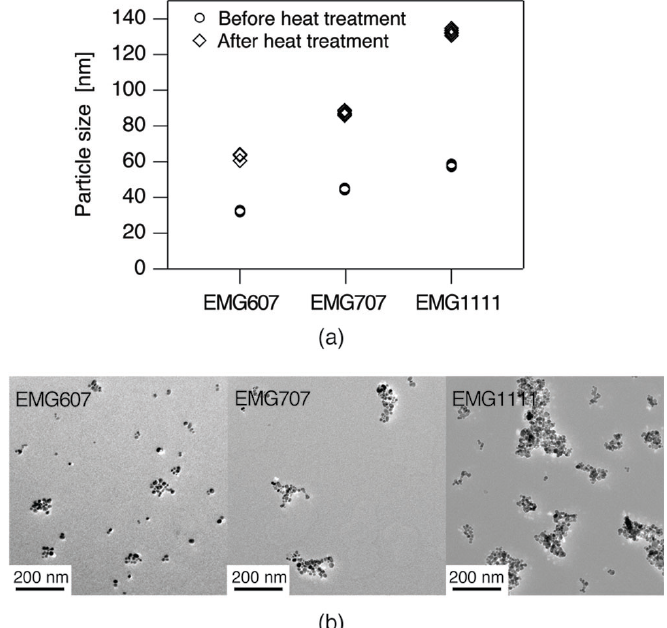
Figure 5. ( a ) Particle size distribution of EMG607, EMG707 and EMG1111 magnetic nanoparticles before and after heat treatment in PCR thermal cycles; ( b ) TEM image of EMG607, EMG707 and EMG1111 magnetic nanoparticles after heat treatment in PCR thermal